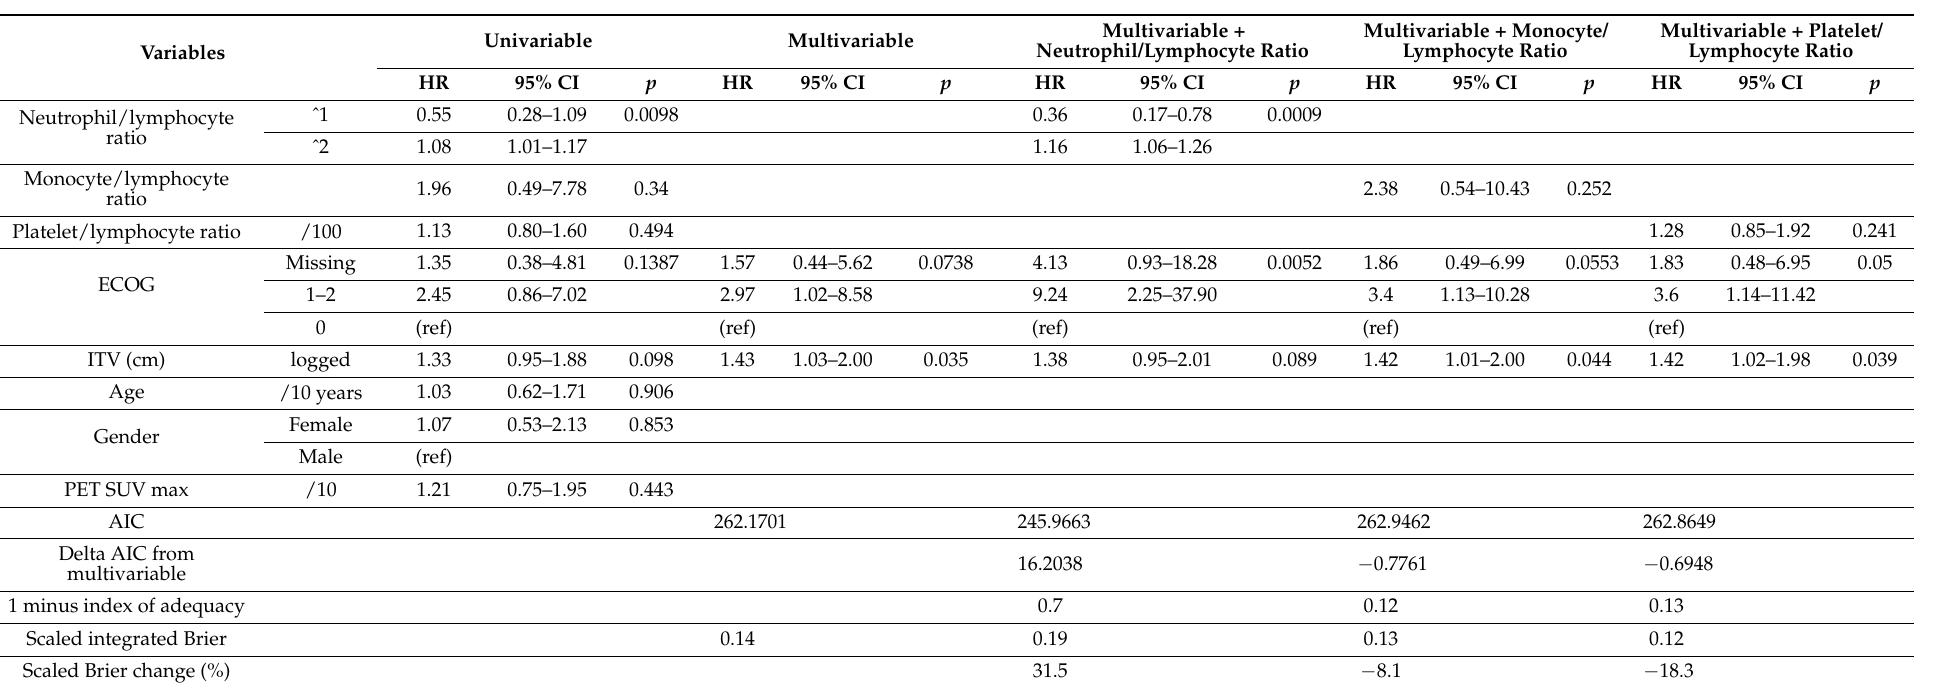
Table 3. Regression model for